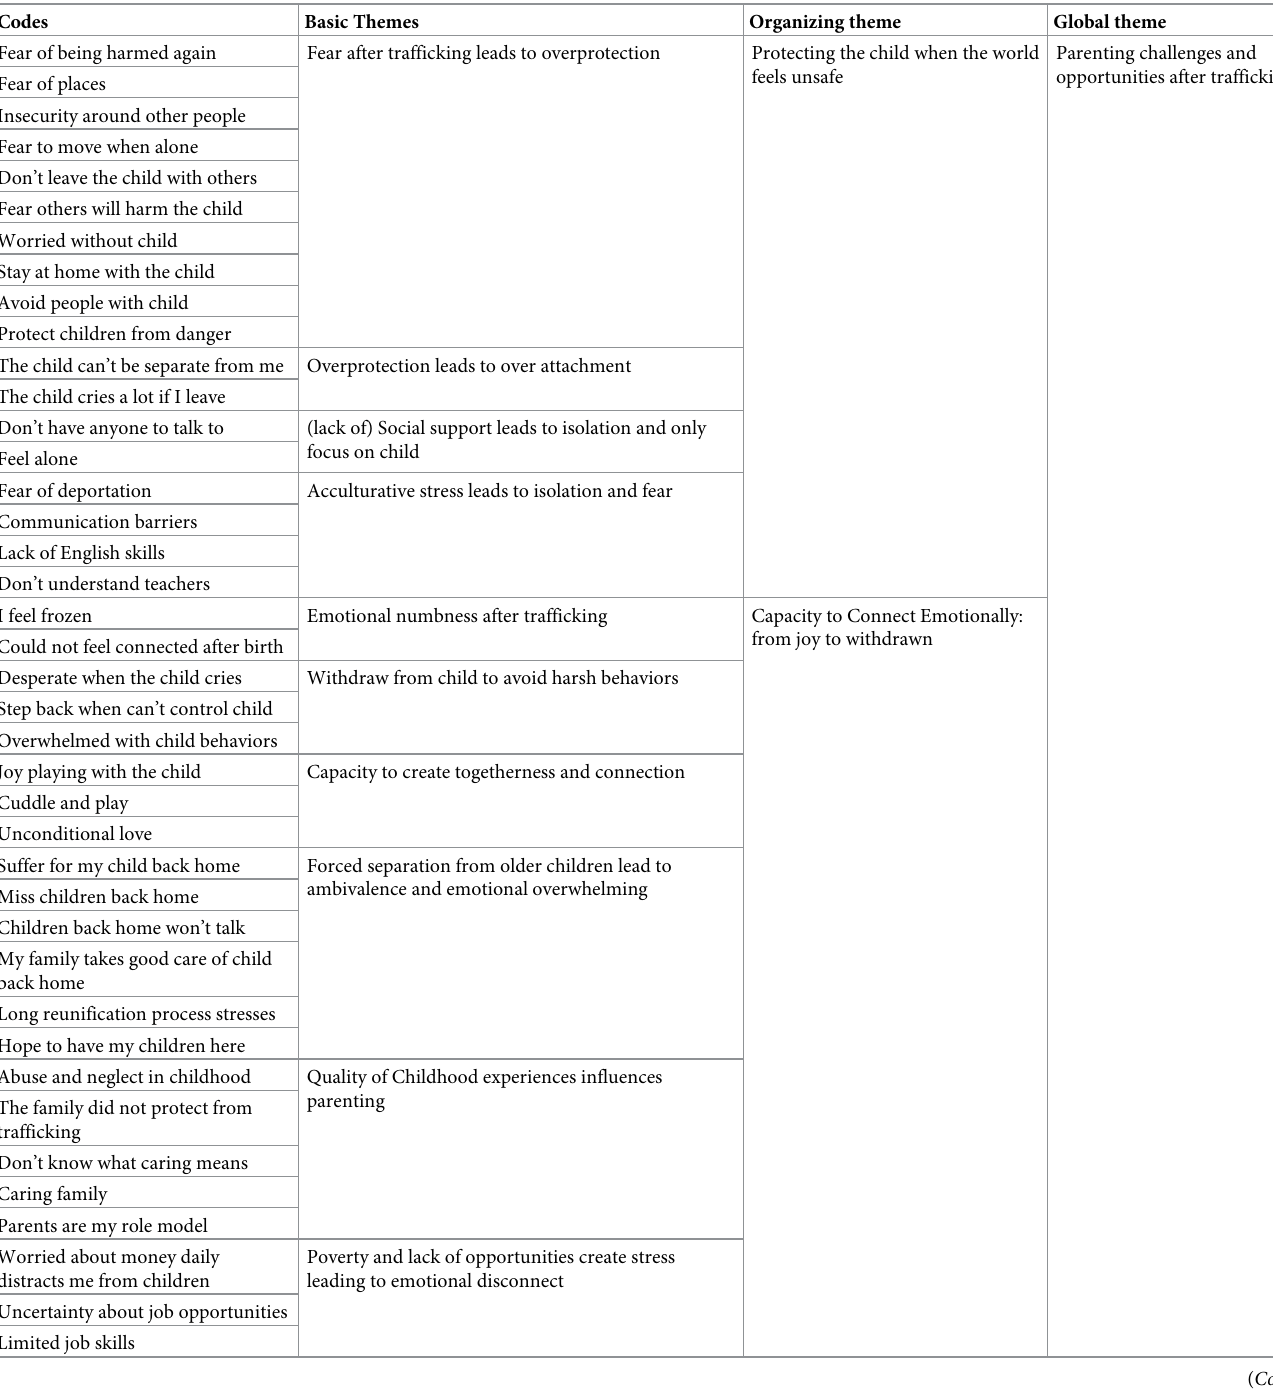
Table 1. Thematic network analysis: From basic themes to global